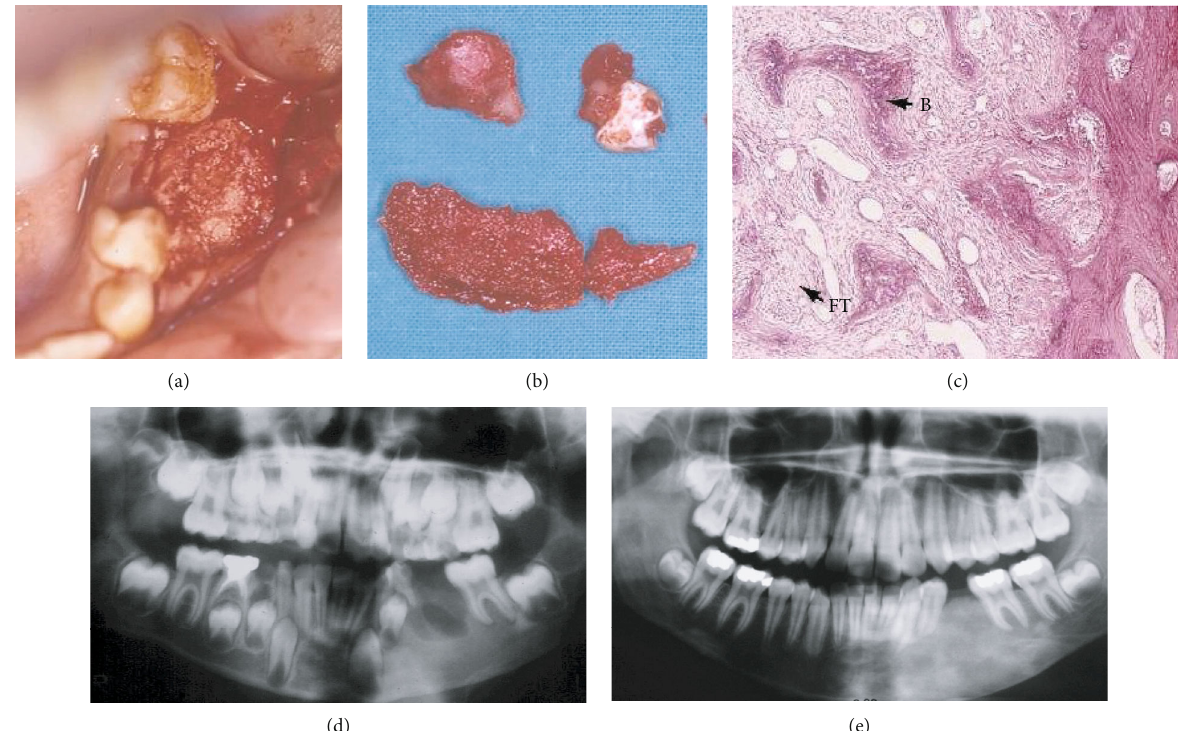
Figure 2: (a) Clinical view of the excess bone. (b) The excised bone with the dental germ. (c) HE × 10 showing irregularly shaped trabeculae of immature bone within proliferating fi broblastic tissue (B: bone; FT: fi brous tissue). (d) One-week panoramic radiograph. (e) Five-year panoramic